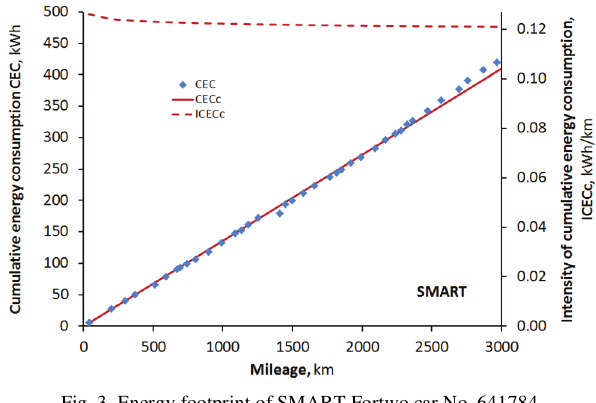
Fig. 3. Energy footprint of SMART Fortwo car No. 641784